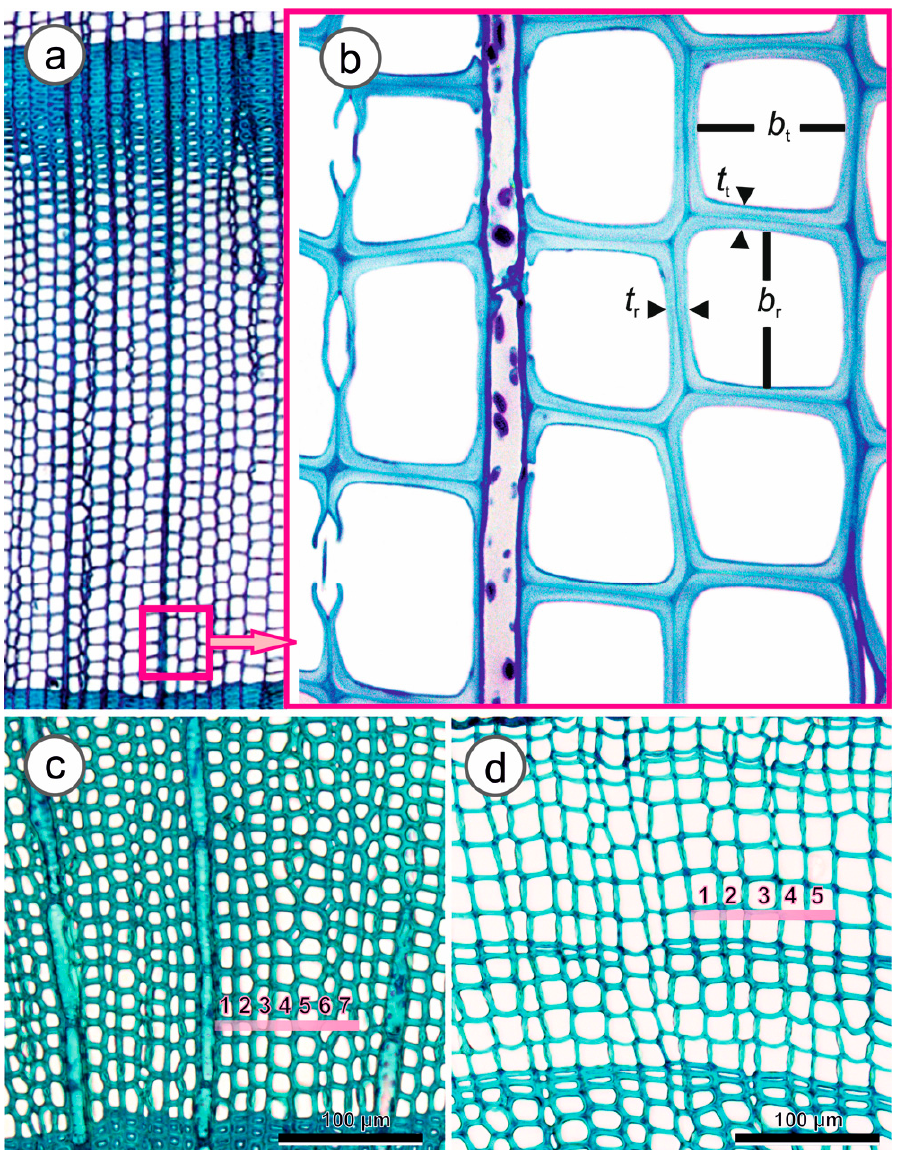
Figure 1. Description of anatomical traits; ( a ) one annual ring of Picea abies stem wood; ( b ) anatomical traits measured in earlywood; ( c ) Abies nordmanniana stem wood; ( d ) Taxodium distichum branch wood; the pink bars in ( c , d ) indicate regions of interest for counting of radial cell files in earlywood; b r radial tracheid lumen diameter; b t tangential tracheid lumen diameter; t r radial tracheid double cell wall thickness, t t tangential tracheid double cell wall thickness.